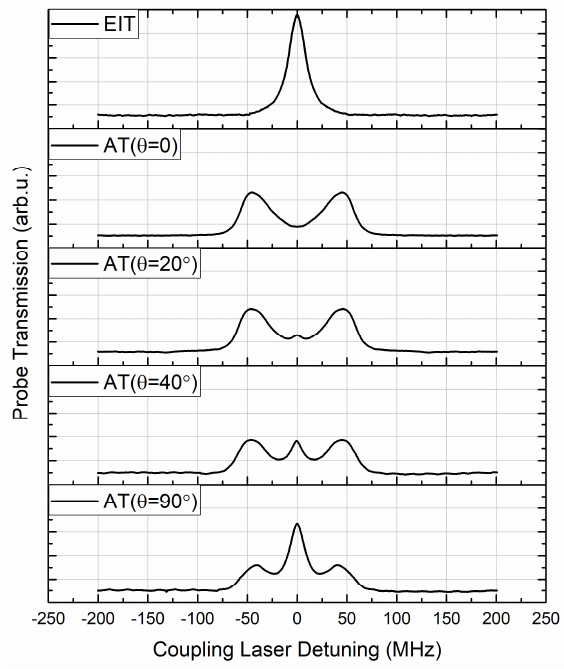
Figure 7. Typical measured transmission spectroscopy of the probe laser in conditions of different E-field polarizations. The top curve noted as “EIT” is the EIT spectroscopy of the probe laser without any incident RF E-field. The other curves are the AT splitting in the presence of a 15.09 GHz E-field. The lineshape differences are due to the relative angle ( θ ) between the E-field vector and laser polarization.